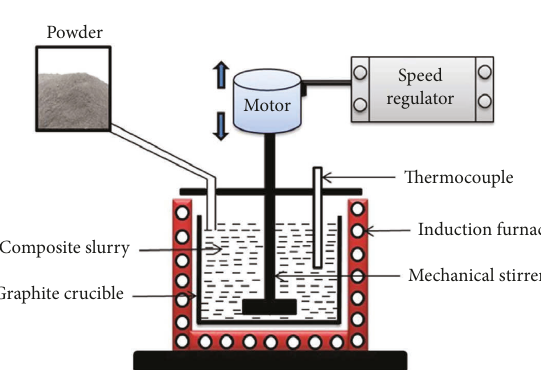
Figure 1: Schematic diagram of stir casting setup.